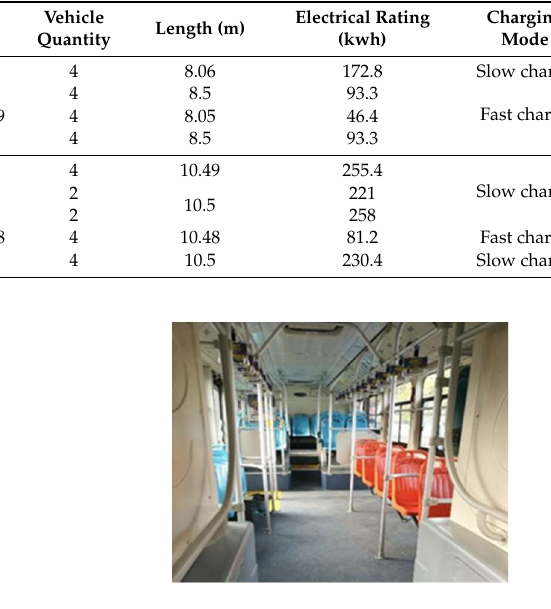
Figure 1. BYD brand.